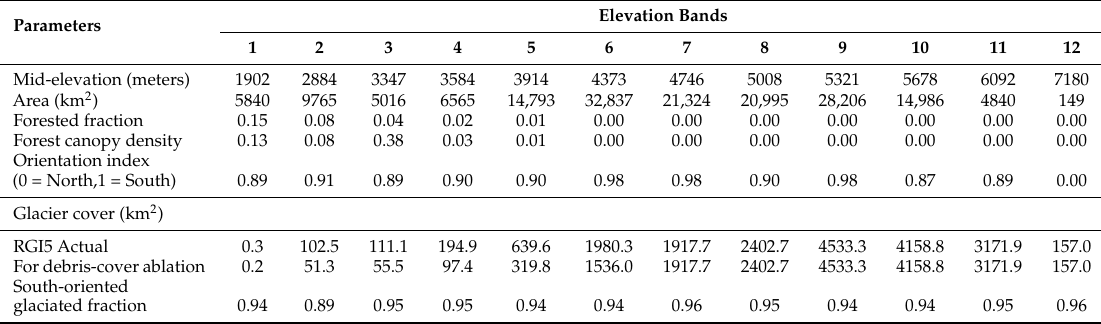
Table 3. Geophysical characteristics of the UIB watershed by elevation zone. Elevation is given in meters while areas are given in km 2